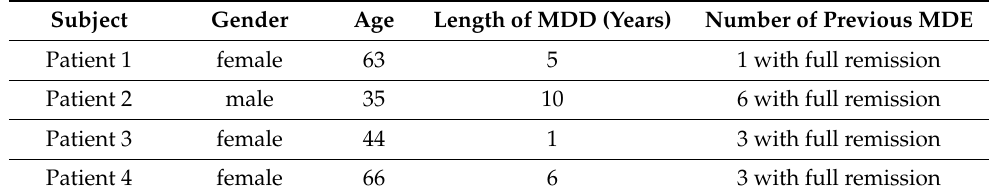
Table 1. Patients’ data and MDD details.